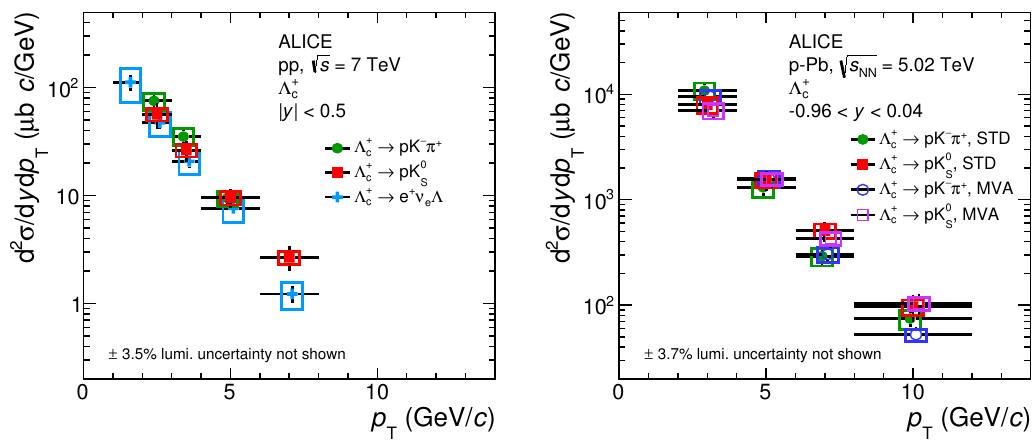
p s = 7 TeV p s NN = 5 : 02